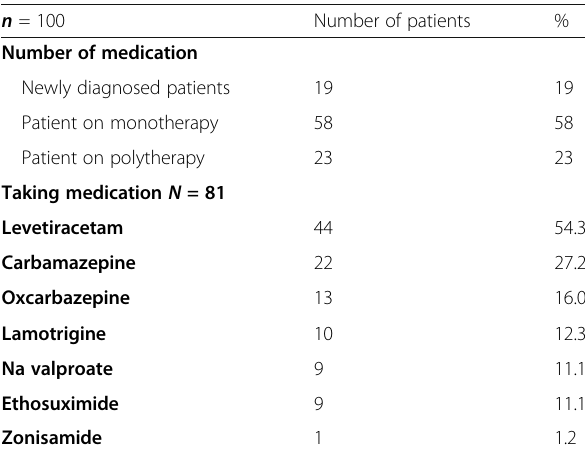
Table 3 Distribution of antiepileptic medications among patients